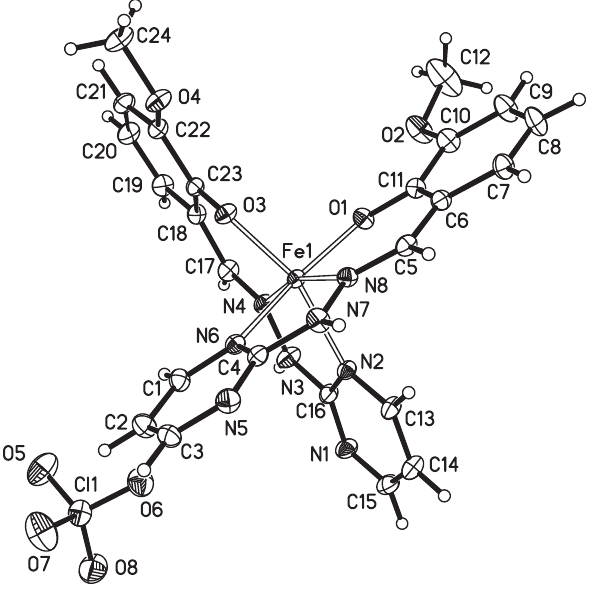
Table 1: Data collection and handling.